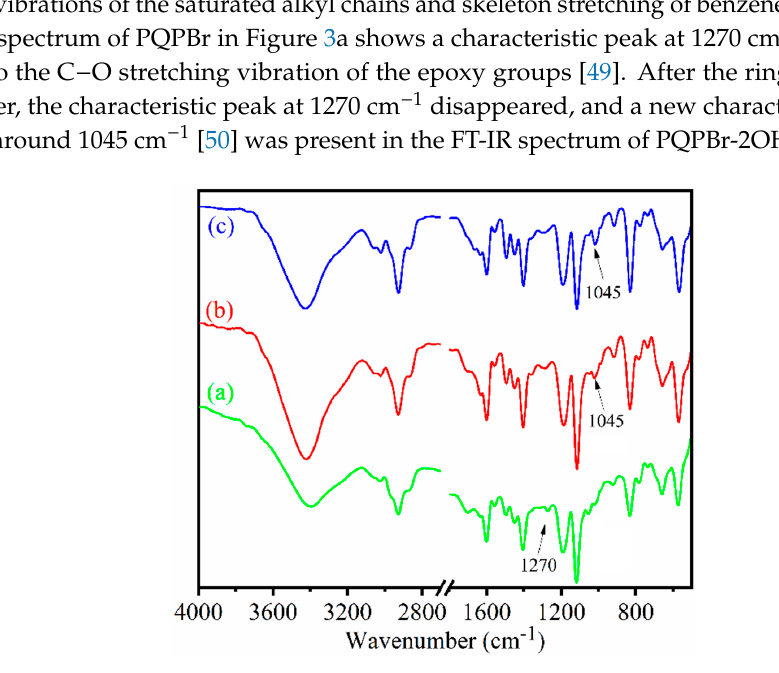
Figure 3. Fourier transformed infrared (FT ‐ IR) spectra of ( a ) PQPBr, ( b ) PQPBr ‐ OH, and ( c ) PQPBr ‐ 2OH.